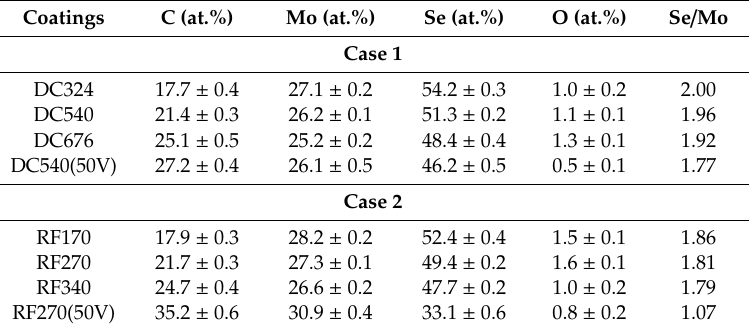
Table 2. Chemical composition and Se / Mo of the